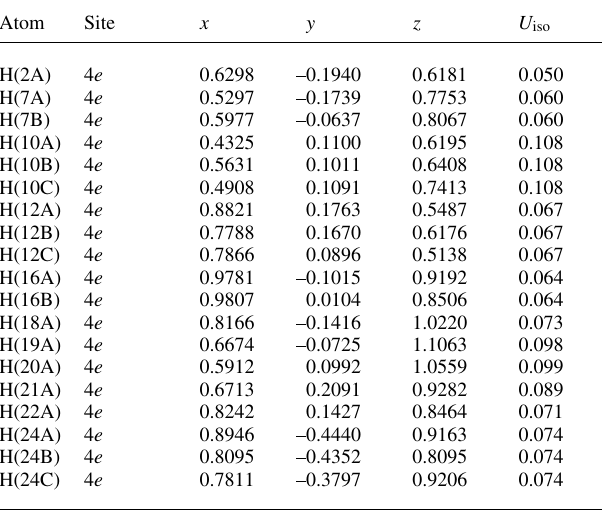
Table 2. Atomic coordinates and displacement parameters (in Å 2 )